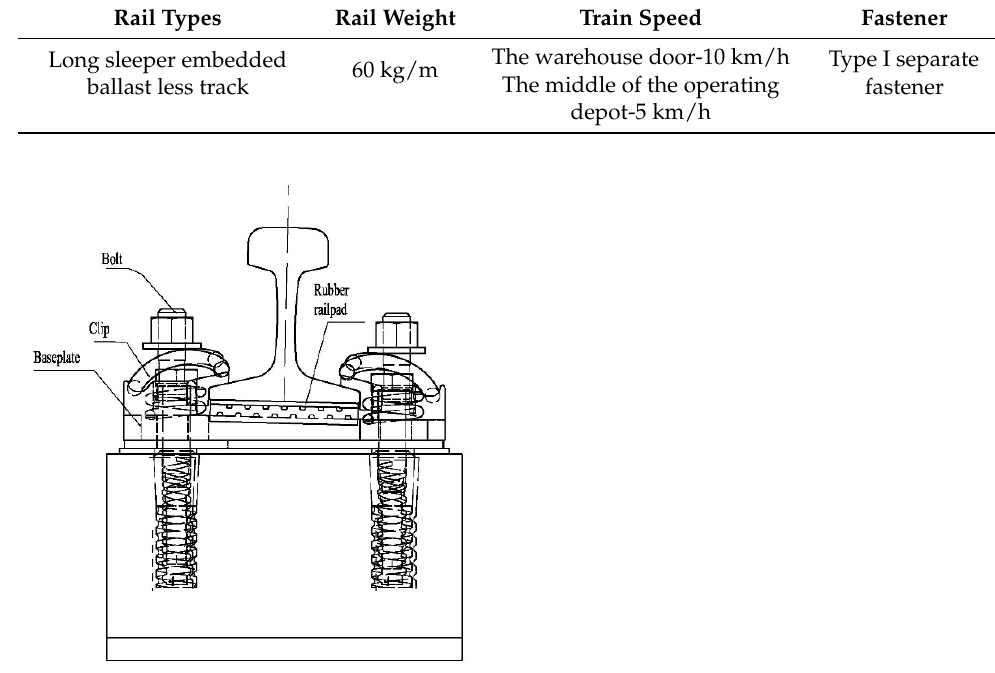
Figure 3. The sectional view of the over-track building. To consider the vibration comfort in the rooms with different usage functions, field experiments were conducted to measure the amplitude in the drawing room and bedroom of each test floor, as shown in Figure 4. When a train passes, the vertical vibrations in a